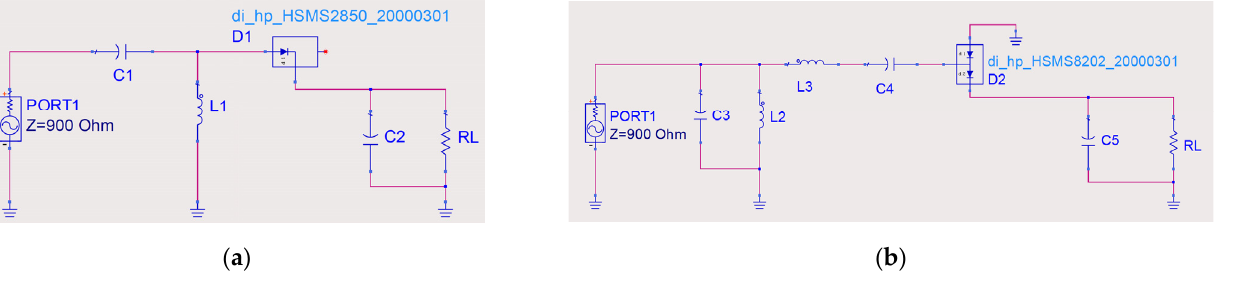
Figure 7. Schematic of the proposed voltage doubler rectifier in ADS. Schematic diagram of ( a ) the single series diode rectifier and ( b ) the voltage multiplier rectifier proposed in the ADS. Here, C1 = 4 pF, C2 = C5 = 1000 pF, C3 = C4 = 0.2 pF, L1 = 22 nH, L2 = 2.2 nH, L3 = 1.5 nH, ( a ) RL = 1000 Ω , and C1 = 4 pF, C2 = C5 = 1000 pF, C3 = C4 = 0.2 pF, L1 = 22 nH, L2 = 2.2 nH, L3 = 1.5 nH, ( a ) RL = 1000 Ω ( b ) RL = 600 Ω .